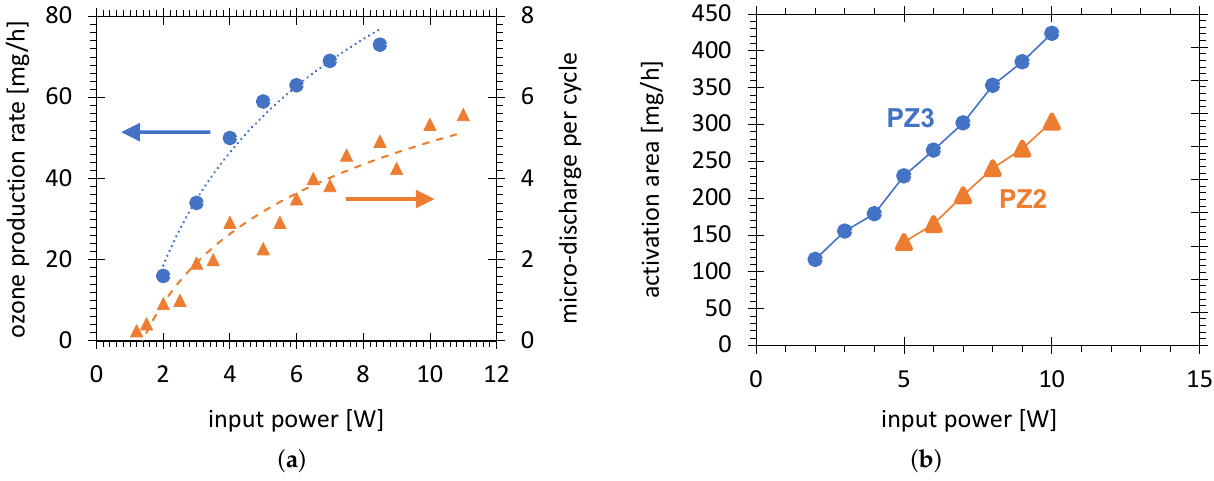
Figure 8. Performance of the piezobrush ® PZ3 as a function of CeraPlas™F input power. ( a ) ozone production rate and number of micro-discharges per oscillation cycle [11]; ( b ) activation area for piezobrush ® PZ3 and for piezobrush ®